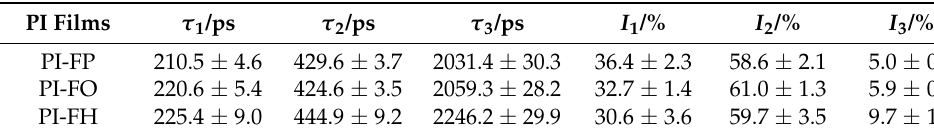
Figure 4. Positron life spectrum of the PI films. Table 1. The positron life time parameters of PI films.